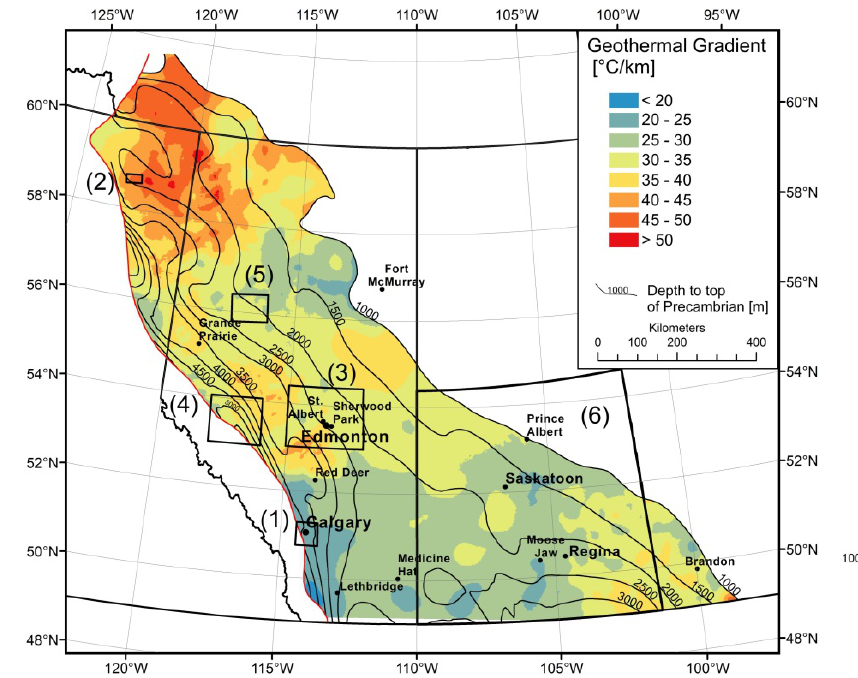
Figure 4. Geothermal gradient of the WCSB based on 68,377 gradient values from 26,492 wells; map was calculated using the simple kriging algorithm. Black boxes represent the location of previous geothermal studies (see Table